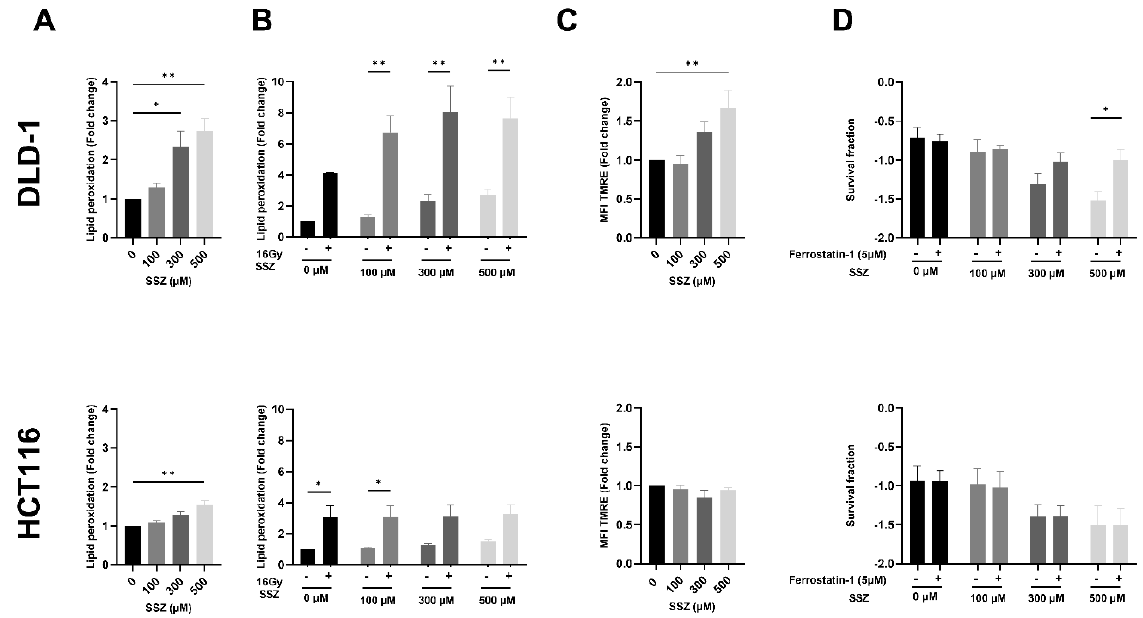
Figure 5. Synergistic effect of SSZ and RT on ferroptosis induction in the DLD-1 cell line under hypoxic conditions. DLD-1 and HCT116 cells were treated with SSZ/Ferrostatin-1 (16 h) under hypoxic conditions (1%), and the induction of ferroptosis was determined. ( A ) The amount of lipid peroxidation after SSZ treatment was evaluated using the C11BODIPY dye in DLD-1 (top) and HCT116 (bottom) cell lines. ( B ) The amount of lipid peroxidation after SSZ treatment + RT (16Gy) 16 h after RT was determined in DLD-1 (top) and HCT116 (bottom) cell lines. ( C ) Mitochondrial membrane potential determination by a TMRE staining and flow cytometry was performed in DLD- 1 (top) and HCT116 (bottom) cell lines. ( D ) The survival fraction after RT with 8Gy + SSZ and Ferrostatin-1 treatment was determined in DLD-1 (top) and HCT116 (bottom) cell lines. Data are represented as mean ± SEM, n ≥ 3. A two-way ANOVA followed by a Dunnett’s or Bonferroni multiple comparison test, or a one-way ANOVA followed by a Dunnett’s multiple comparison test, was performed for statistical analyses. * p < 0.05, ** p < 0.01.